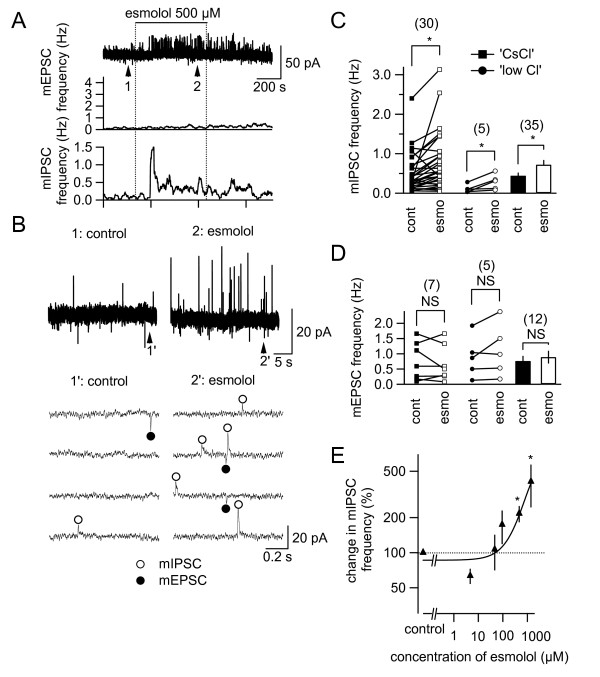
Selective increase in miniature inhibitory postsynaptic current (mIPSC) frequency by esmolol in neurons of the caudal part of the spinal trigeminal nucleus (Sp5c). (A) Top: the membrane current recording of an Sp5c neuron at a holding potential of -40 mV. Esmolol was applied at the horizontal bar. Middle: the time course of the changes in miniature excitatory postsynaptic current (mEPSC) frequency with esmolol. Bottom: the time course of the changes in mIPSC frequency with esmolol. The abscissae of these graphs are identical (time; 5 min/div). (B) 1 and 2 are time-extended traces taken at the points 1 and 2 in the trace in A (top). mIPSCs and mEPSCs (outward and inward events, respectively) are marked with open circles above the traces and filled circles below the traces, respectively. (C) and (D) Summaries of the effects of esmolol on mIPSC and mEPSC frequency, respectively. "cont", mPSC frequency observed in 3-min control period before esmolol application (filled markers and bars); "esmo", those at 10-min application of esmolol (500 μM; open markers and bars). The numbers in parentheses indicate the number of neurons tested and were used for the statistics. Left, results of recordings with "CsCl-based" internal solution (squares) under pharmacological isolation of mIPSCs (C) and mEPSCs (D); center, results of recordings with "low-Cl" internal solution in five cells (circles) in which mIPSCs (C) and mEPSCs (D) were simultaneously recorded (see Methods); right bars, pooled summaries based on the results with "CsCl" internal solution and "low-Cl" solution. *, P < 0.05; NS, not significantly different from pre-administration values (100%). Paired t-test. (E) Concentration-response relationship between esmolol and the changes in mIPSC frequency. The curve indicates the best-fit Hill equations for the data for esmolol. The number of neurons used to estimate the mean values and curve-fitting was 39 (control); 5 (5 μM); 5 (50 μM); 4 (100 μM); 35 (500 μM); 7 (1500 μM). *, P < 0.02; Mann-Whitney's U test; vs. control (no drug application). The horizontal broken line indicates the control values (100%).